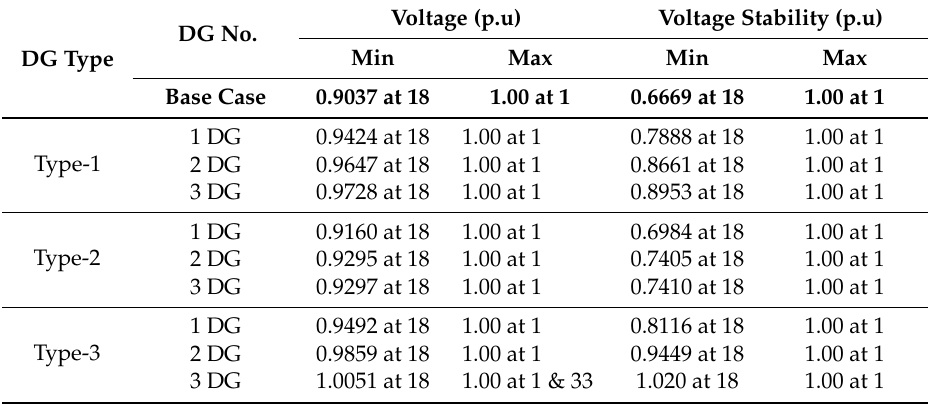
Table 3. The voltage profile and voltage stability of the system for 1st objective